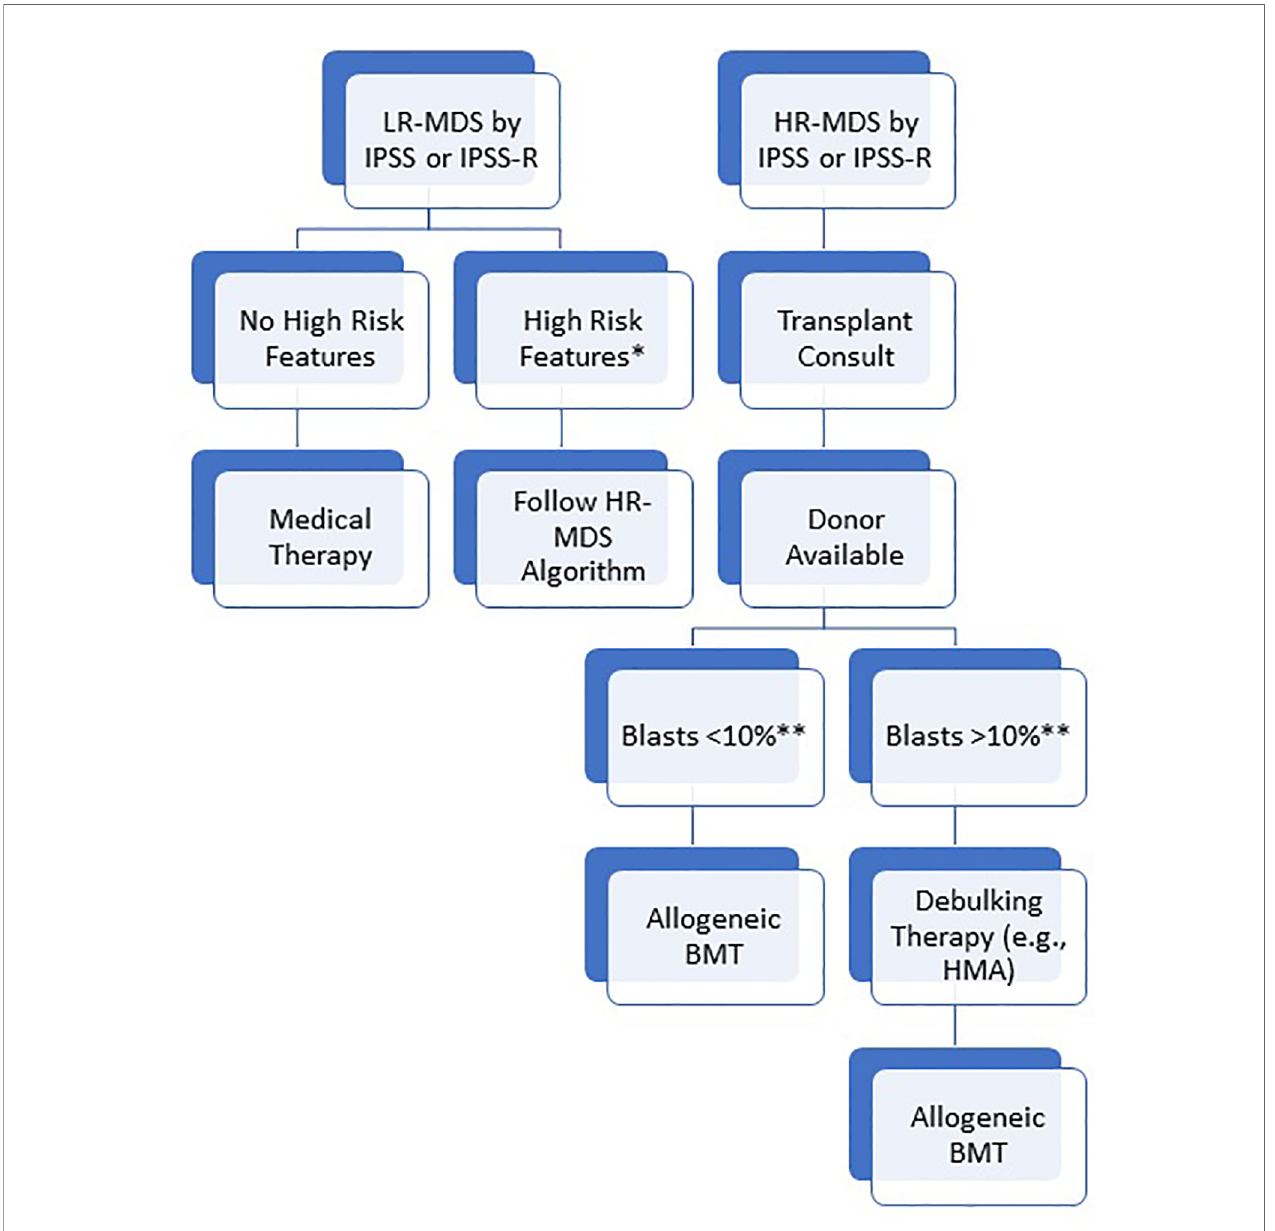
FIGURE 2 | Suggested algorithm for allogeneic BMT. Patients are initially risk strati fi ed based on IPSS or IPSS-R. For high risk patients, transplant consult should be pursued immediately and patients should proceed to transplant as soon as blasts are < 10%. For low risk patients, BMT should still be considered in the presence of high risk features (*high risk somatic mutations including TP53, ASXL1, and RUNX1; Blasts > 10%; transfusion dependence or severe neutropenia despite medical therapy; hypomethylating agent failure). **While a blast percentage below 10% is acceptable to proceed with transplant, the speci fi c threshold is debated and institution dependent. Some centers may consider bridging medical therapy for patients with low blast percentage to maintain low disease burden during the donor search. For patients with an indication, allogeneic BMT should be pursued as soon as the blasts are adequately